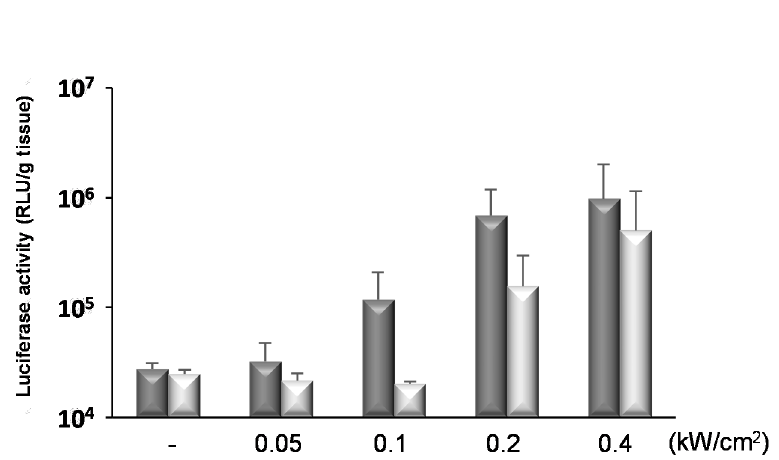
with Tukey’s post-hoc test.